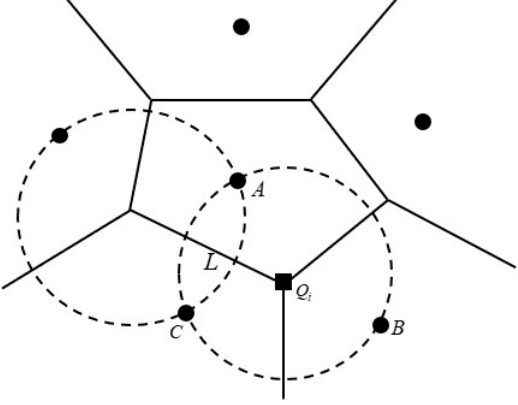
Figure 2. The characteristic of hollow circle in a Voronoi diagram.